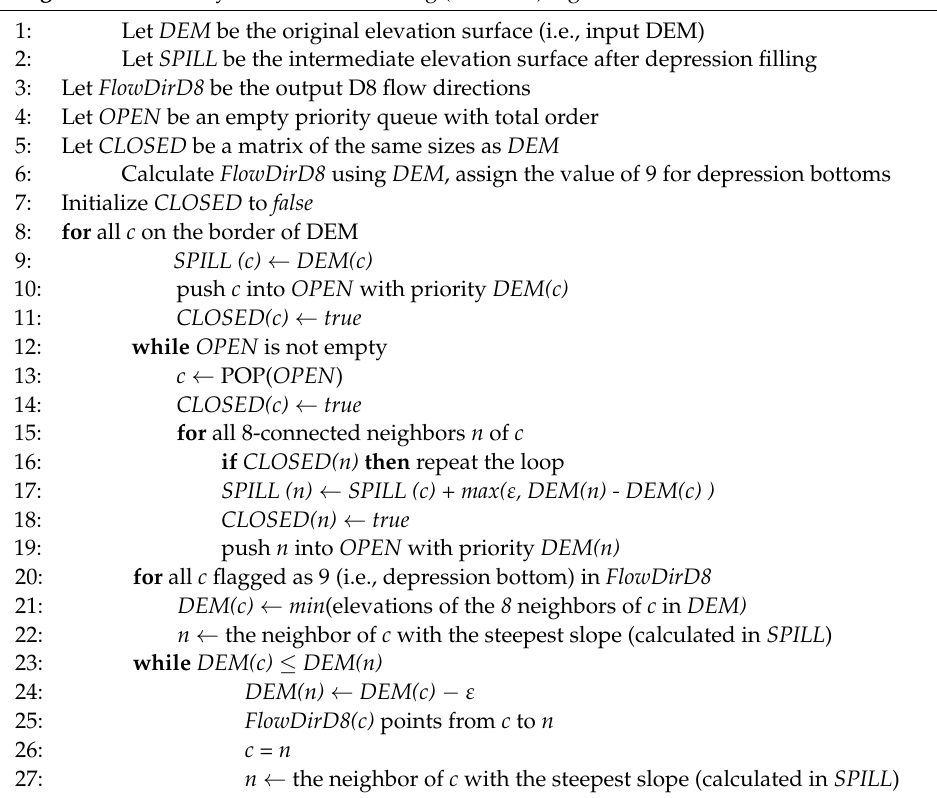
Algorithm 1. Priority-flood-based burning (PF_Burn)